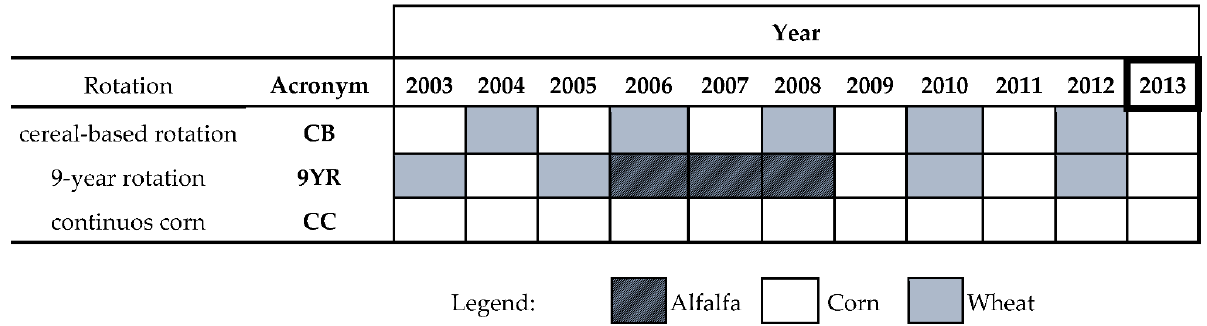
Figure 1. Representation of the rotation from the 2003 until the 2013 (time of soil sampling) season. Each rotation has two field replicates. CC: continuous corn; CB: 2 year cereal-based rotation of corn; 9YR: 9 year rotations consisting of corn-